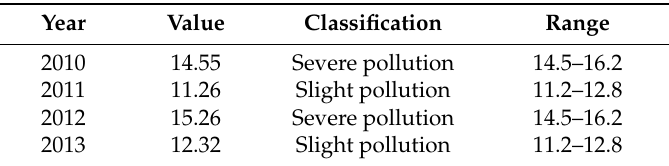
Table 5. Overall water quality assessment